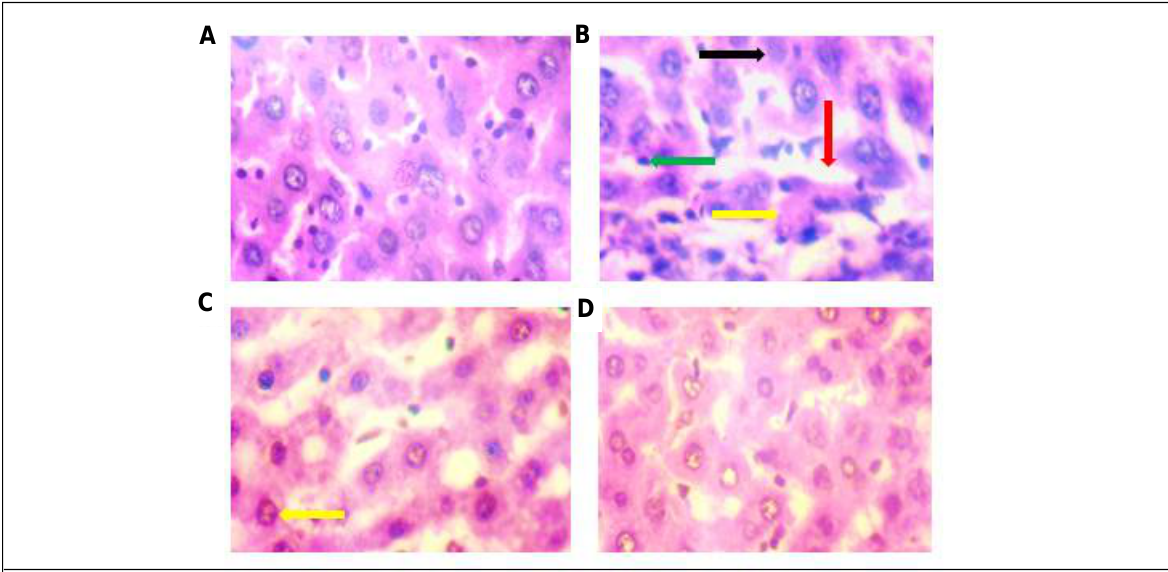
Plate 3: Photomicrograph of liver histology for group A (control group) with normal liver histologic features; group B (induced with 100 mg/kg b.w. of KBrO ) with loss of cyto and histoarchitecture showing dilated portal 3 area (dp), dilated sinusoids (red arrow), hepatocyte necrosis (yellow arrow), karyolysis (black arrow) and pyknosis (green arrow); group C (induced with KBrO and treated with 200 mg/kg b.w. of AETO) showing signs of 3 recovery in the hepatocytes and central vein; group D (induced with 100 mg/kg b.w. of KBrO and treated with 3